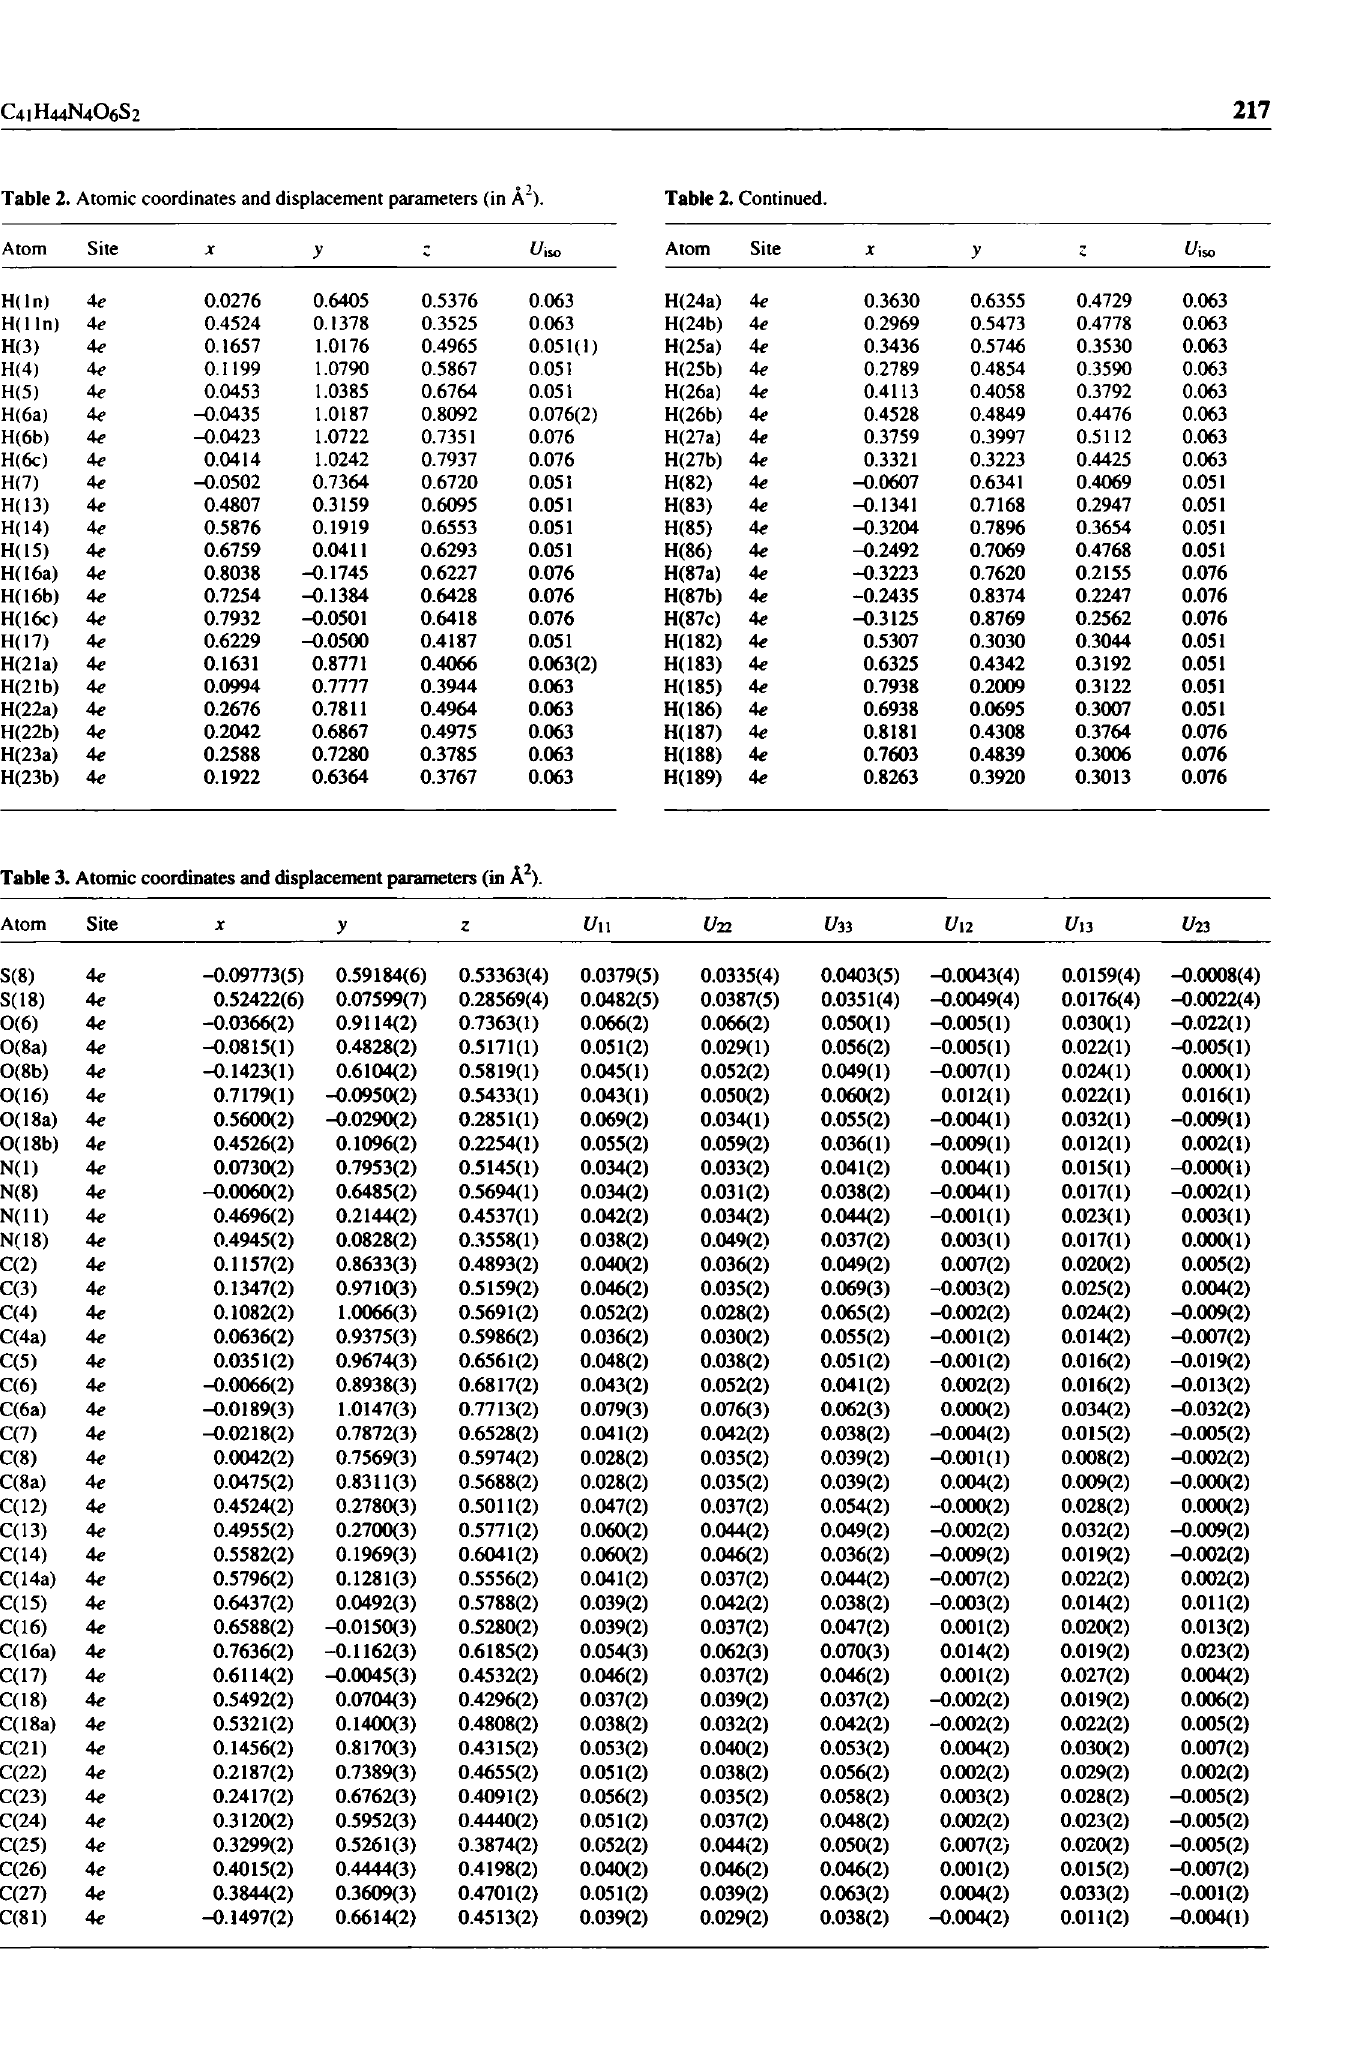
Table 3. Atomic coordinates and displacement parameters (in A 2